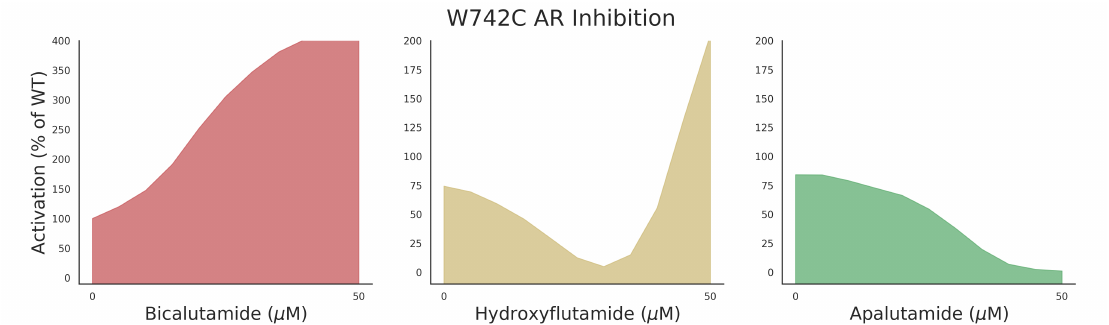
Figure 1. W742C androgen receptor (AR) mutant transcriptional response to increasing dose of anti-androgen. Y-axis corresponds to percent activation in luciferase reporter assay normalized to wild-type (100% indicates same activation as